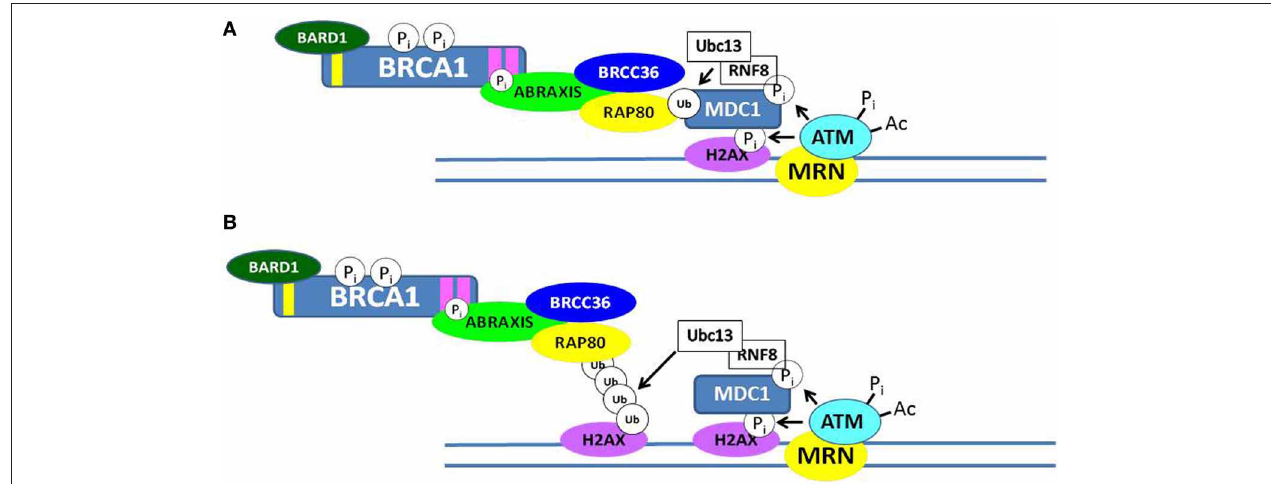
FIGURE 3 | Recruitment of BRCA1 to sites of double-strand DNA breaks. Two possible mechanisms by which the BRCA1 complex A can be recruited to ionizing radiation-induced foci (IRIF) are illustrated in (A,B) . Both involve post-translational modifications of DDR proteins, including phosphorylation and ubiquitination. In (A) , the RNF8/Ubc13 complex ubiquitinates MDC1, and